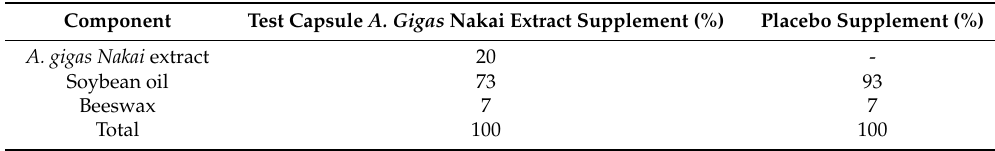
Table 1. Composition of the test product as determined by high-performance liquid chromatography